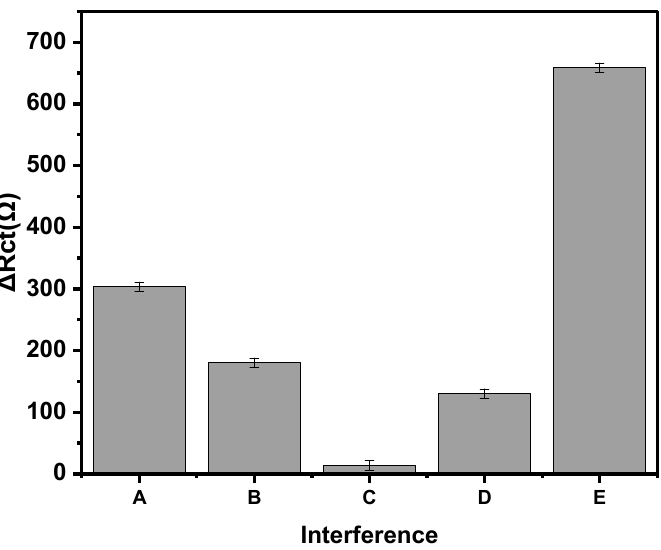
Figure 9. Selectivity of the GFAP biosensor in the presence of different biomolecules in the serum sample. ∆ R ct detected after immobilization of 10 ngmL − 1 CRP (A), 2 mM Cholesterol (B), 2 mM Lysine (C), 2 mgmL − 1 Hemoglobin (D), and 100 pgmL − 1 GFAP (E) prepared in PBS in the presence of [Fe(CN) 6 ] 3 − /4 − with EIS .